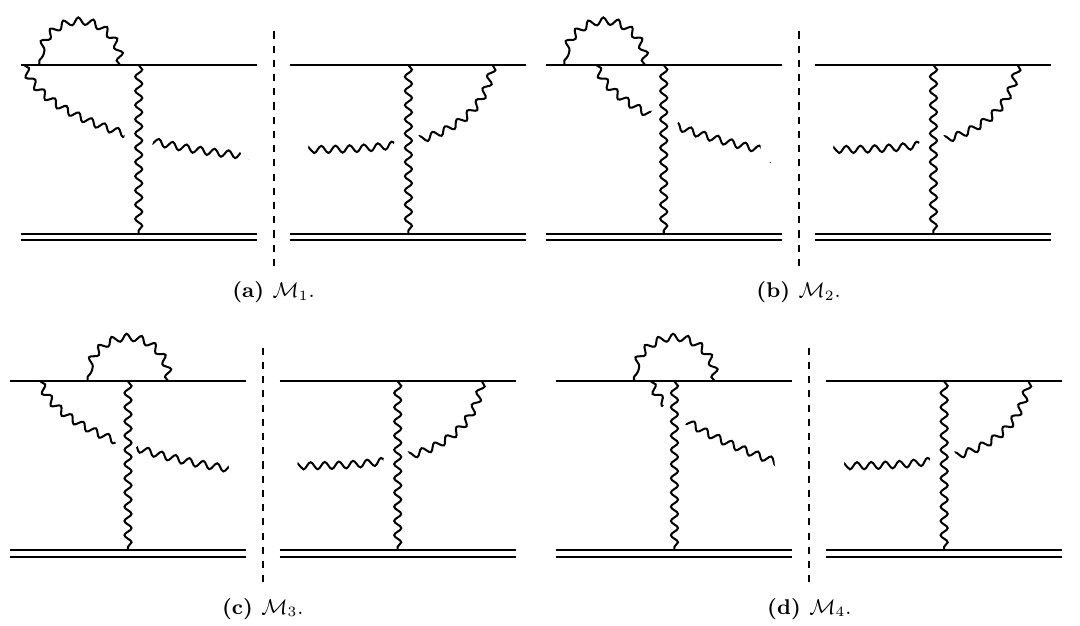
Figure 4 . Interference terms that contribute at leading power in the limit where the emitted photon becomes collinear to the initial-state